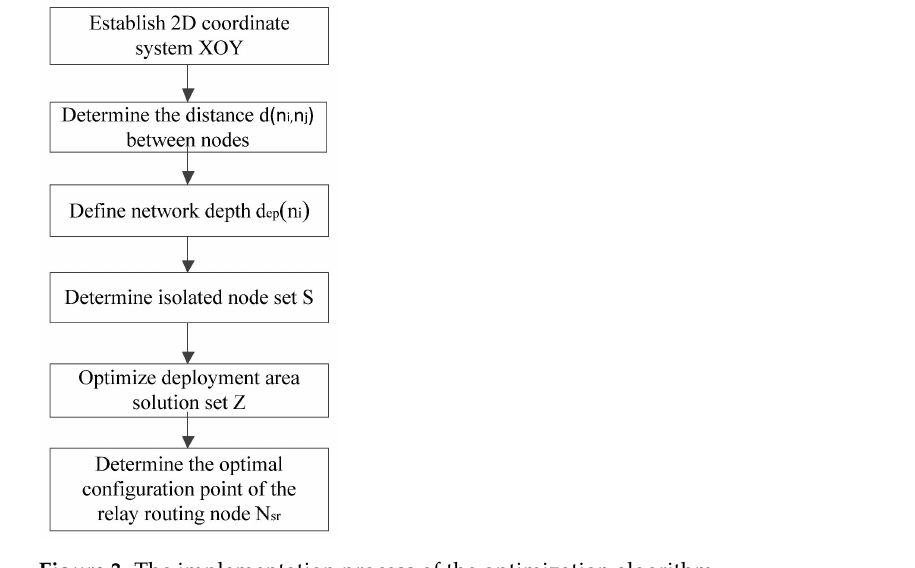
Figure 3. The implementation process of the optimization algorithm. (cid:12) (cid:1) (cid:0) n s ( x s , y s ) S = , defined the isolated boundary point n sl ( x sl , y sl ) as the (cid:12) d ep ( n s ) < 0